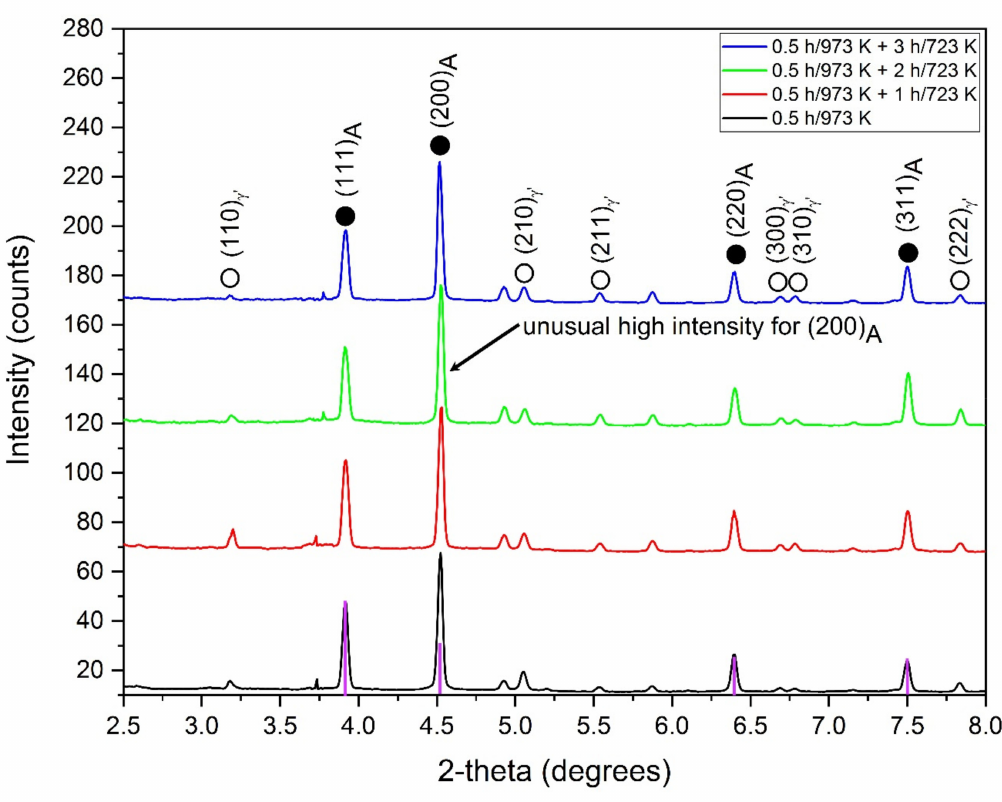
Figure 1. Synchrotron X-ray di ff raction patterns of the annealed NCAT samples of < 001 > orientation aged at 973 K for 0.5 h and then aged at 723 K for variable times. The purple bars indicate the intensities generated by a powder di ff raction of the matrix (theoretical di ff